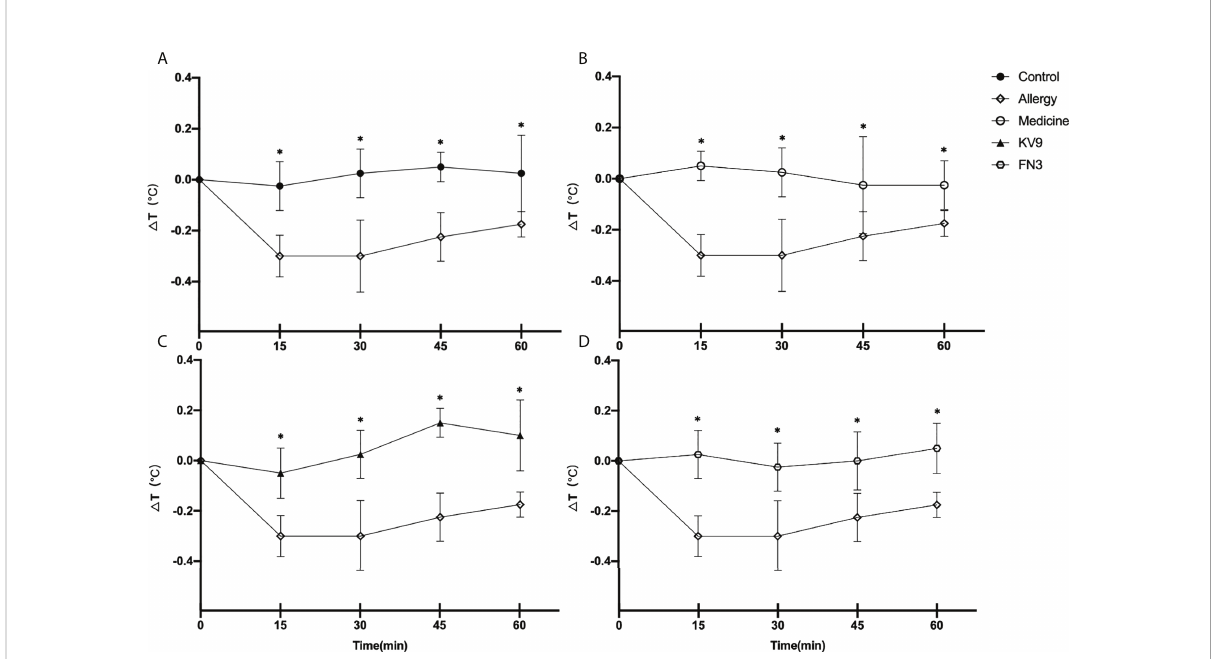
FIGURE 3 Changes in core body temperature at indicated time points following fi rst challenge with b -LG in control (A) , medicine (B) , KV9 (C) , and FN3 (D) group mice compared with mice in the allergy group (* p <